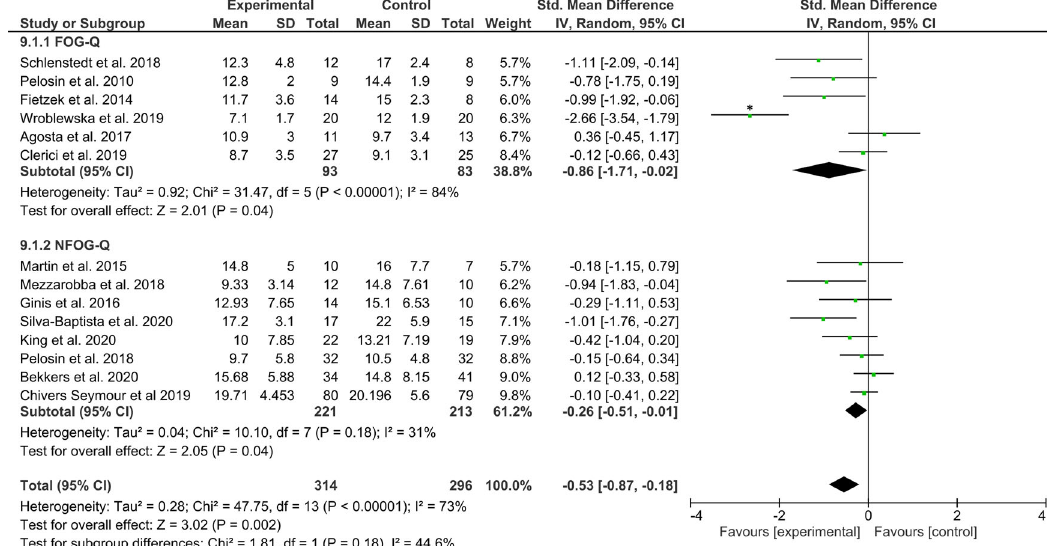
Fig. 6 Secondary analysis comparing all types of training/exercise interventions against any type of control group in studies enrolling the only PD with FOG (i.e., freezers). The studies are arranged per weight of the study as based on sample size; *signi fi cant outliers removed in the sensitivity